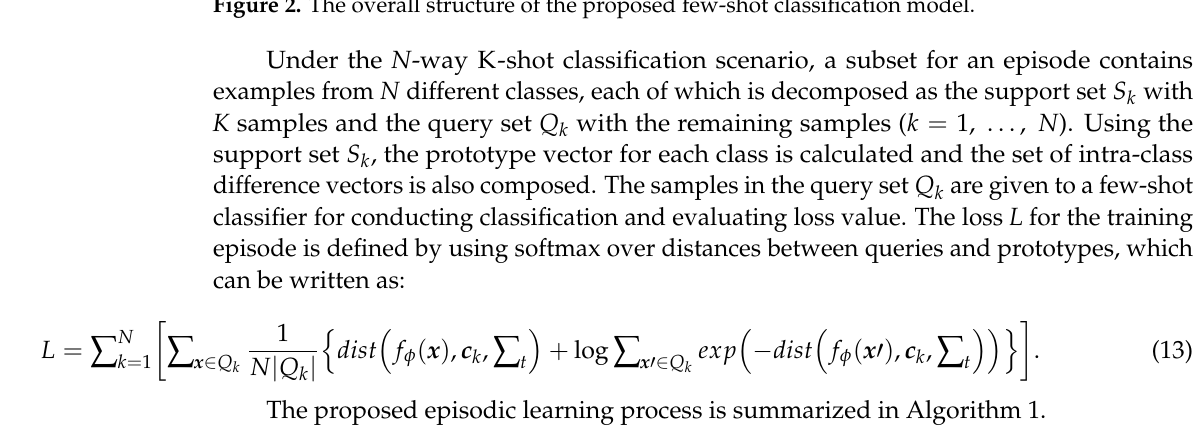
Algorithm 1 A training algorithm for embedding network in N -way K- shot problem. N is the Algorithm 1. A training algorithm for embedding network in N -way K -shot problem. N is the number of classes per episode, K number of classes per episode, K is the number of support samples per class, 𝑁 𝑐𝑙𝑠 is the total number of classes in the training set.